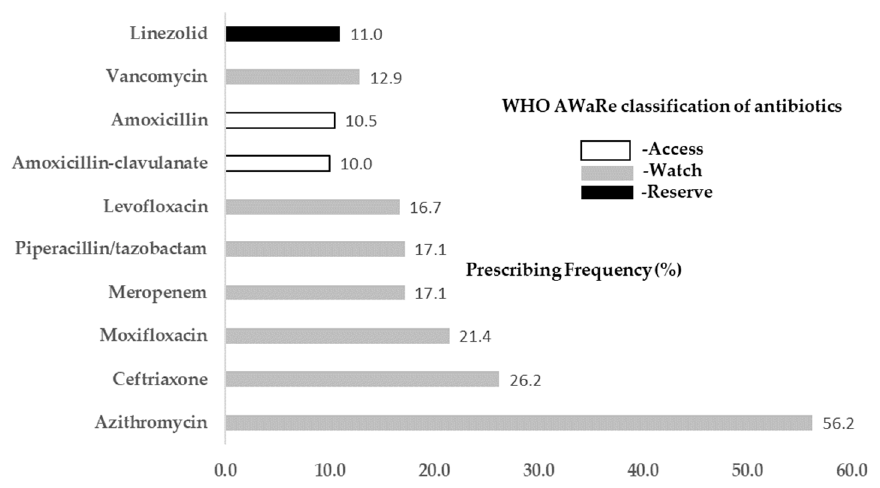
Figure 2. Frequently prescribed antibiotics in COVID-19 patients.